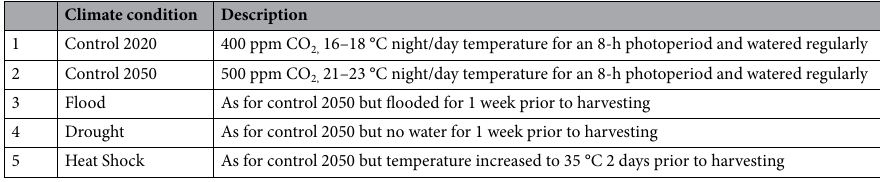
Table 2. Climate